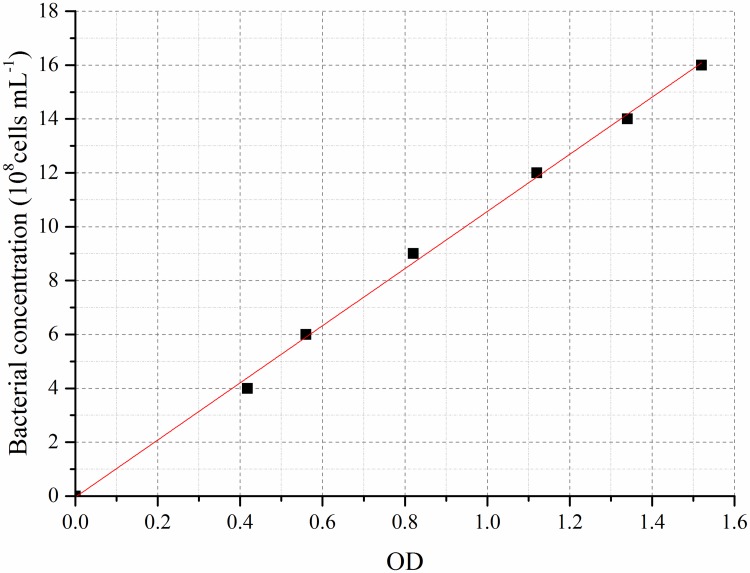
Standard curve for the relationship between the Sporosarcina pasteurii concentration and the OD600 value.